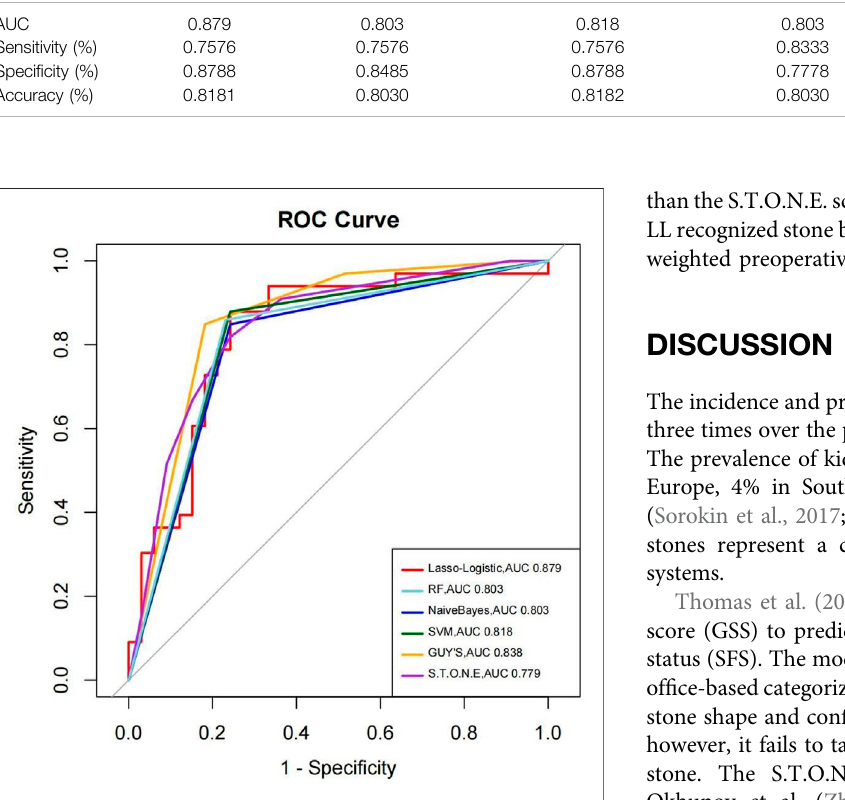
Frontiers in Pharmacology |